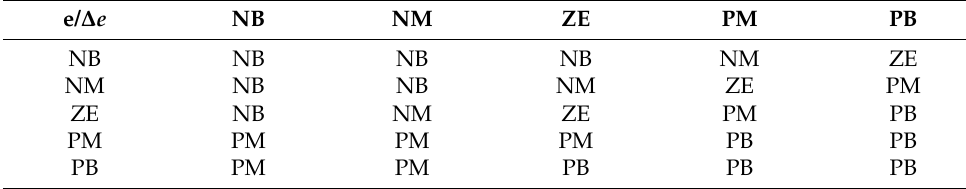
Table 4. Rules for computing fuzzy output.